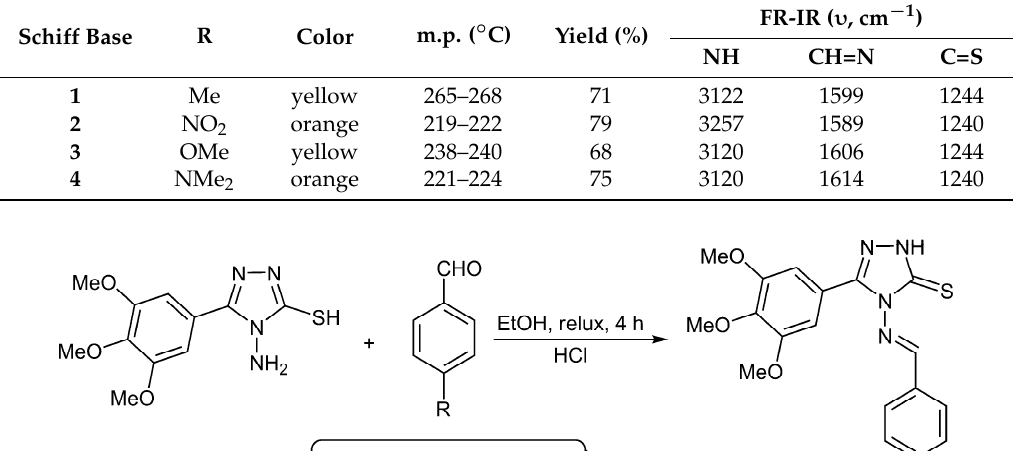
Table 1. Physical properties and some FT-IR spectral data for Schiff bases 1 – 4 .